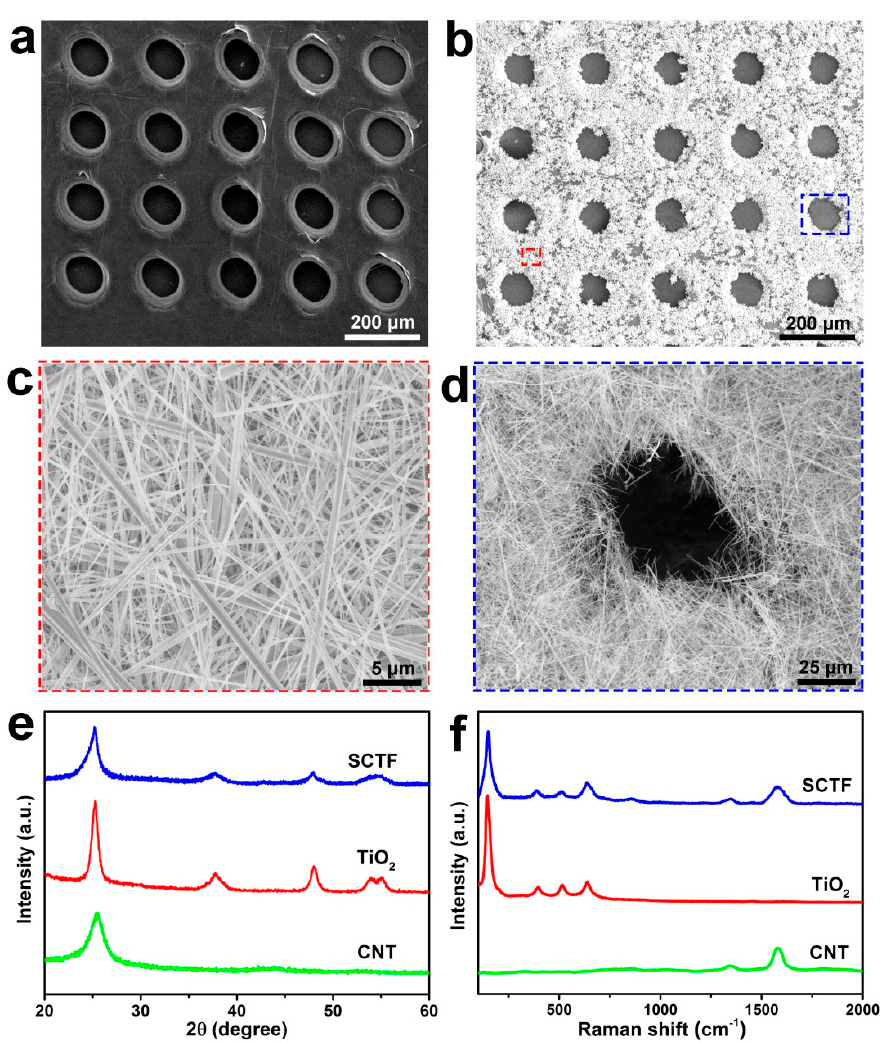
Figure 3. SEM images of a sieve-like CNT film ( a ) and SCTF at low and high magnifications ( b – d ). XRD patterns ( e ) and Raman spectra ( f ) of CNT, TiO 2 and